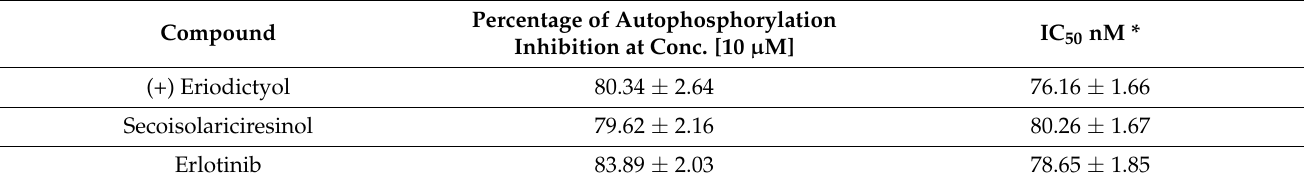
Table 5. EGFR-inhibition activity of the tested compounds against EGFR-PK assay.